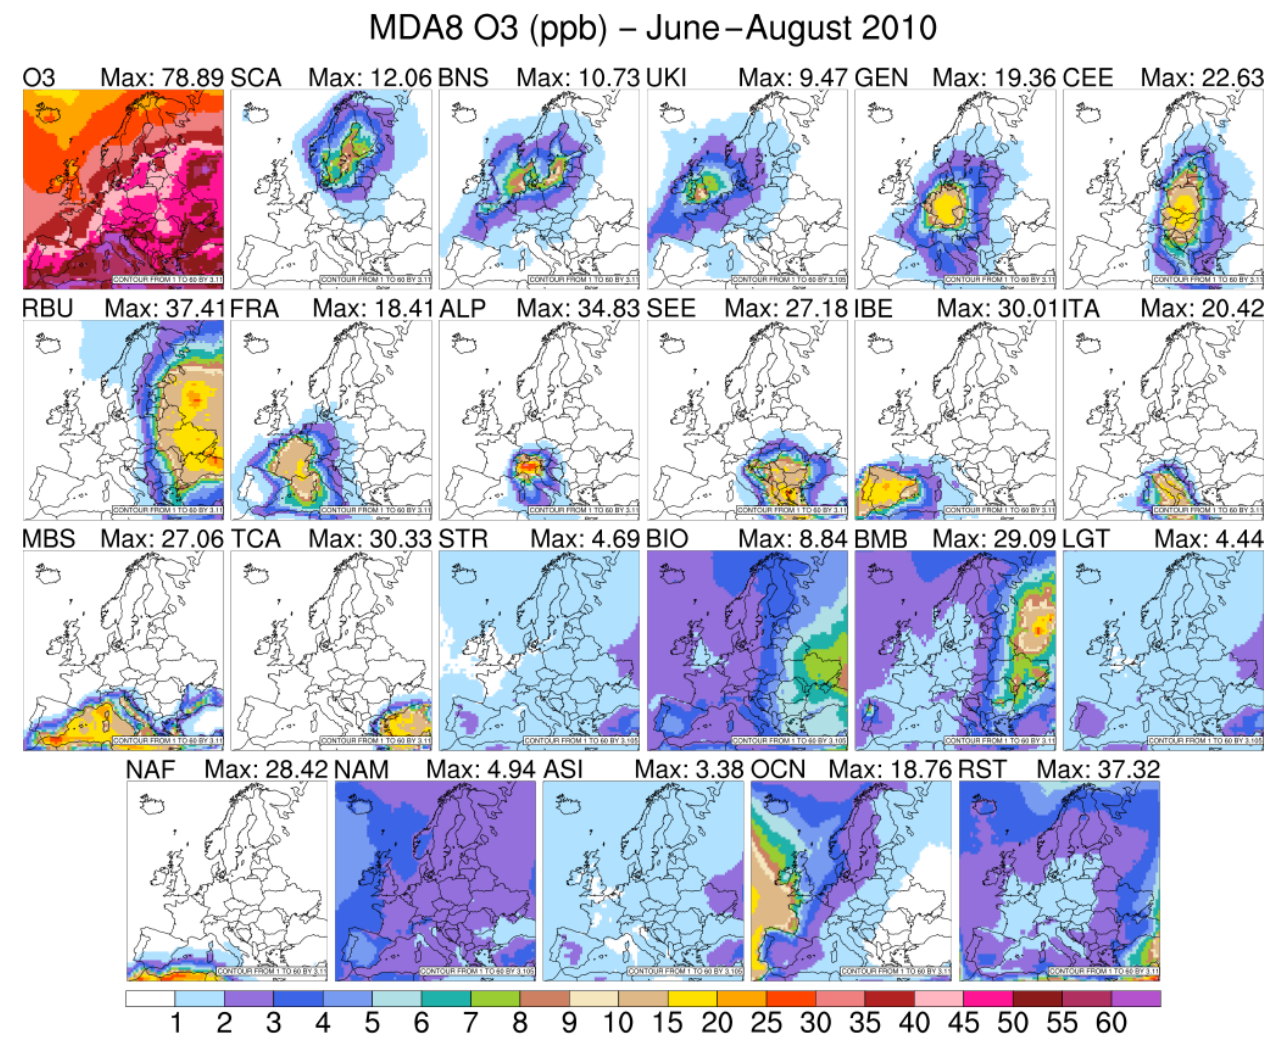
Figure 3. Same as Fig. 2, but for the June–August 2010